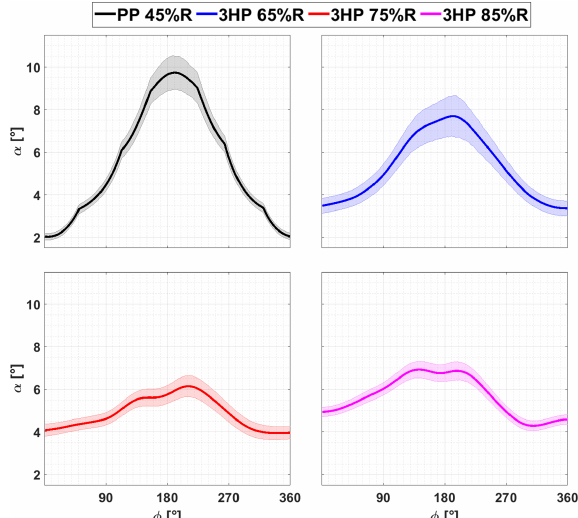
Figure D1. AoA results from the pressure tap and three-hole-probe approaches with their uncertainties. The pitch angles θ = 0 ◦ and the yaw angle is ψ = − 30 ◦ .